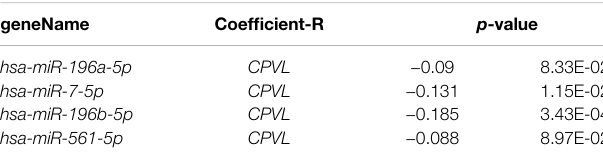
TABLE 2 | Correlation between CPVL and miRNA.